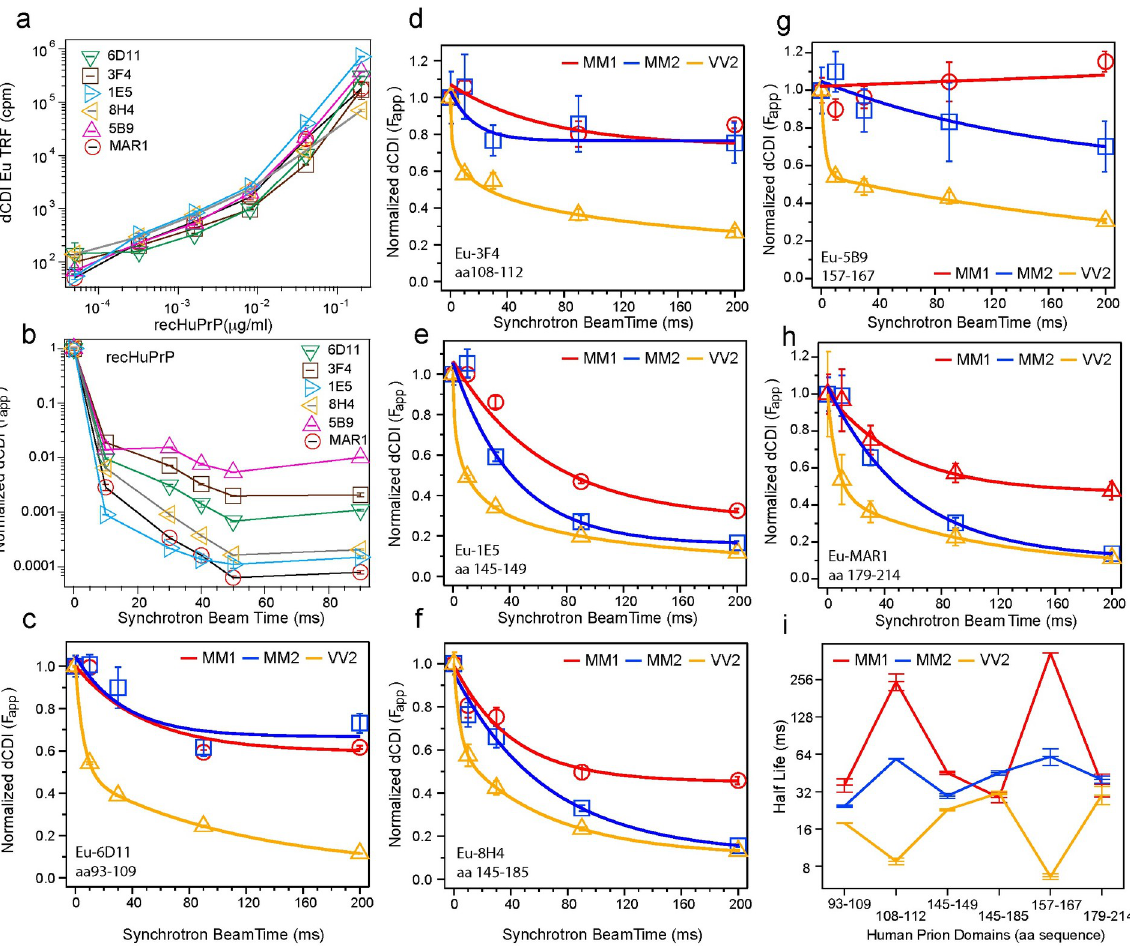
Fig 2. The • OH modification rates of different antibody epitopes in recombinant human monomeric α -helical PrP (recHuPrP) and in MM1, MM2, and VV2 sCJD prions monitored with dCDI. ( a ) Calibration of dCDI with non-irradiated recHuPrP and Europium-labeled mAb 6D11 (aa 93–109), 3F4 (aa 108–112), 1E5 (aa 145–149), 8H4 (aa 145–185), 5B9 (aa 157–167) and MAR1 (aa 179–214). ( b ) Parallel rapid drop in normalized antibody dCDI signals of synchrotron irradiated recHuPrP. Time course of epitope modification monitored in sCJD MM1 (red), MM2 (blue) and VV2 (yellow) prions with mAb ( c ) Eu-6D11, ( d ) Eu-3F4, ( e )Eu-1E5, ( f ) Eu-8H4, ( g ) Eu-5B9, and ( h ) Eu-MAR1. ( i ) Half-life of different epitopes in MM1 (red), MM2 (blue) and VV2 (yellow) sCJD prions in synchrotron beam. Each dCDI datapoint is an average ± standard error obtained in triplicate experiments normalized from the time resolved fluorescence (TRF) signal of europium in counts per minute (cpm).